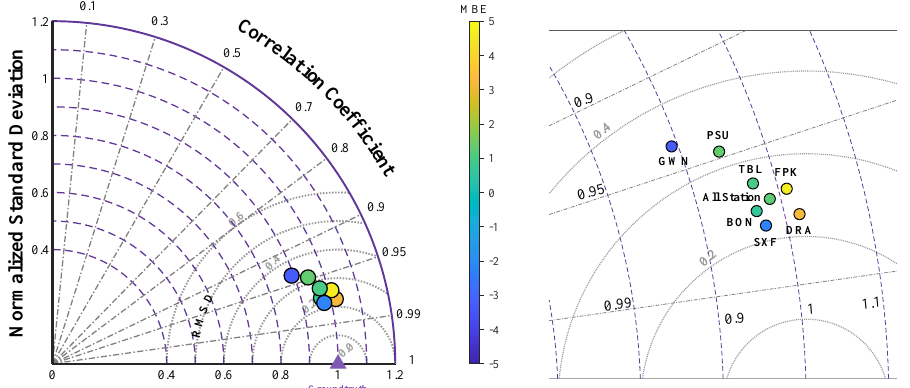
Figure 10. The Taylor diagrams for evaluating DRFCN+RF on SURFRAD-2017 dataset. The point labeled ground truth represents a reference value. The color of each circle represents the nMBE